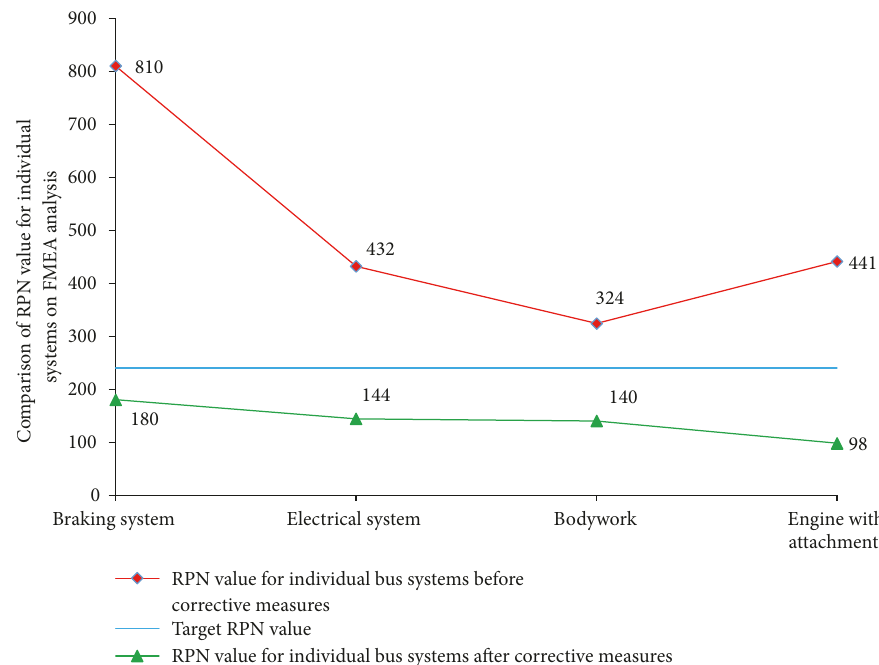
Figure 9: Comparison of RPN values for each of the bus systems before and after corrective actions based on FMEA analysis based on FMEA.